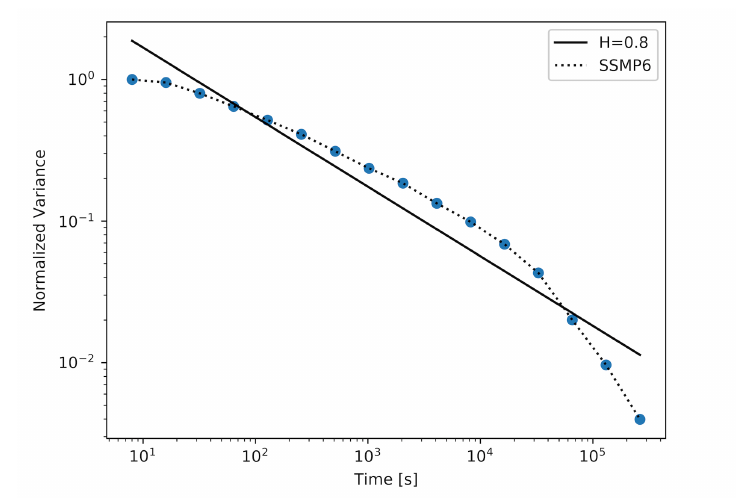
Figure 3. The aggregate variance of the sample in several time scales with the SSMP model, n = 6.